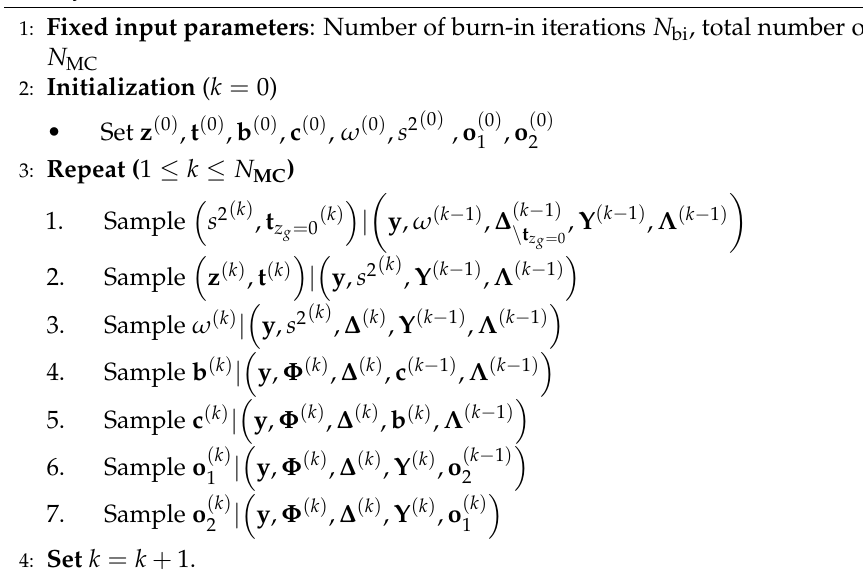
Algorithm 1 Split and augmented—partially collapsed Gibbs sampling algorithm for activity estimation in PGET—version